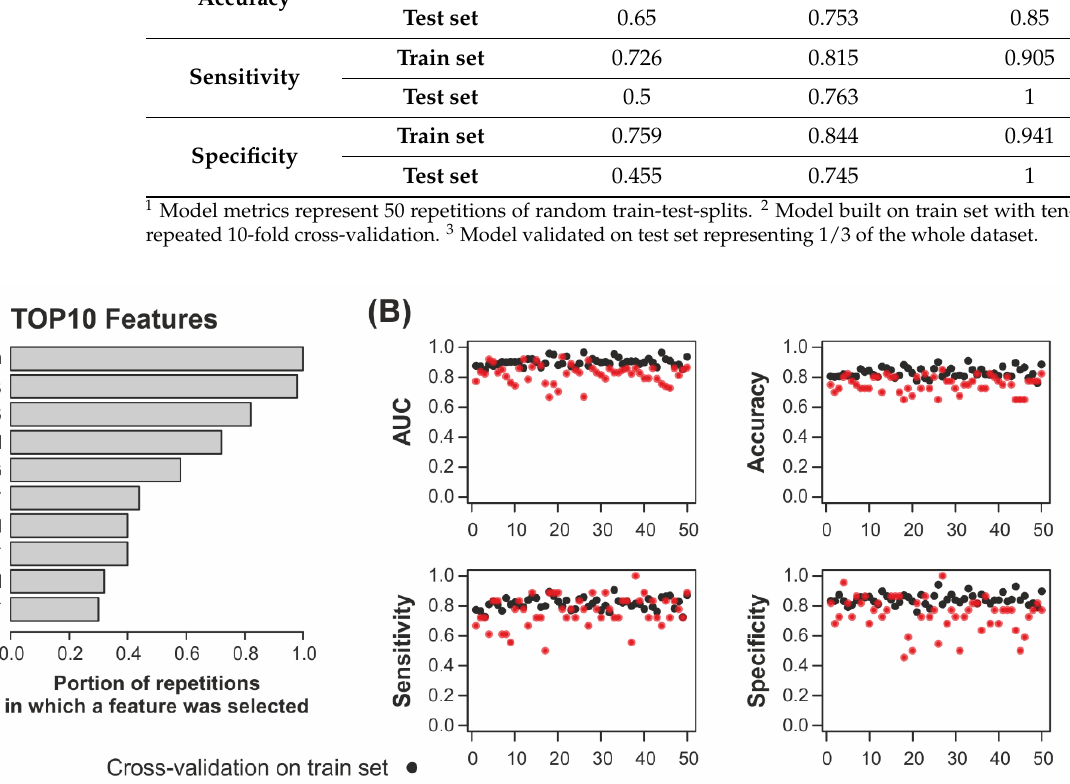
Figure 5. Results of intra-set validation for the comparison AC vs. COPD. The dataset was randomly split into train and test sets for 50 repetitions. The random forest model was developed with a ten-times-repeated 10-fold-cross-validation on the train set and validated on the test set. ( A ) Top 10 list of the most frequently selected features (i.e., proteins, represented by gene names (except Ig κ Chain)). ( B ) Characteristics of the random forest classifier for cross-validation on the train sets (black) and validation on the test sets (red), respectively, were plotted against the number of repetitions. Table 2. Characteristics of random forest classifiers with the highest AUCs *.